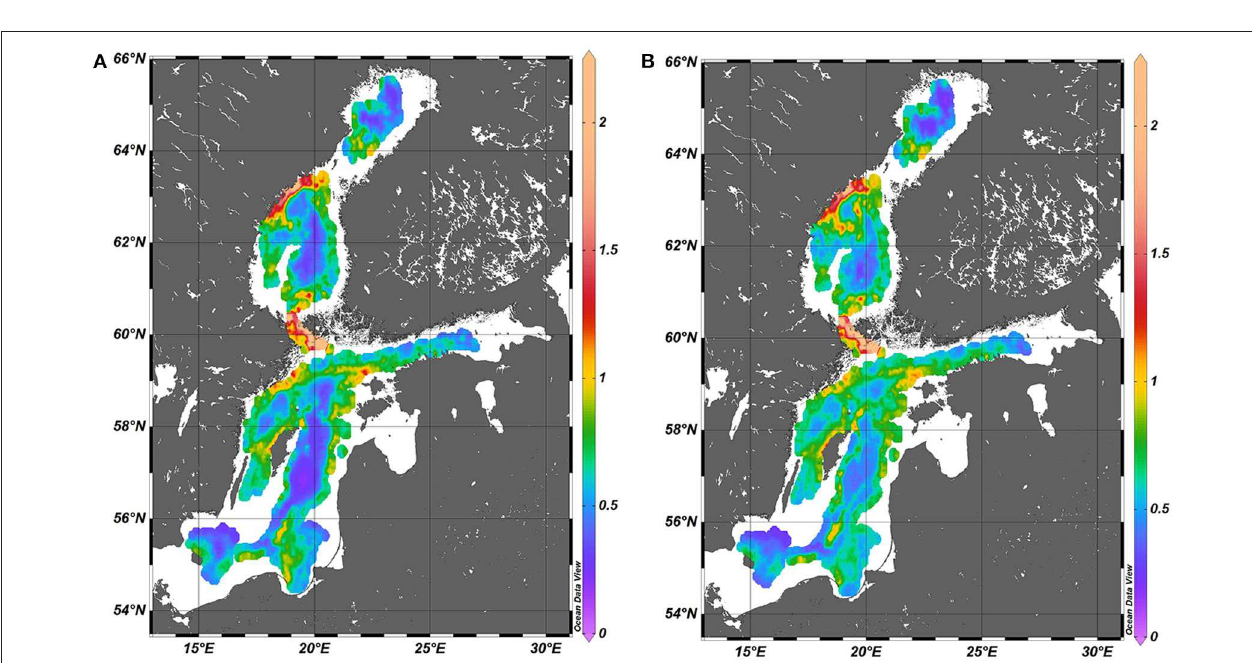
FIGURE 6 | Spatial distribution of the spectral amplitude (Equation 4) of vertical fluctuations of the seasonal pycnocline (m) in 1961–1965 (A) and 2000–2005 (B) .